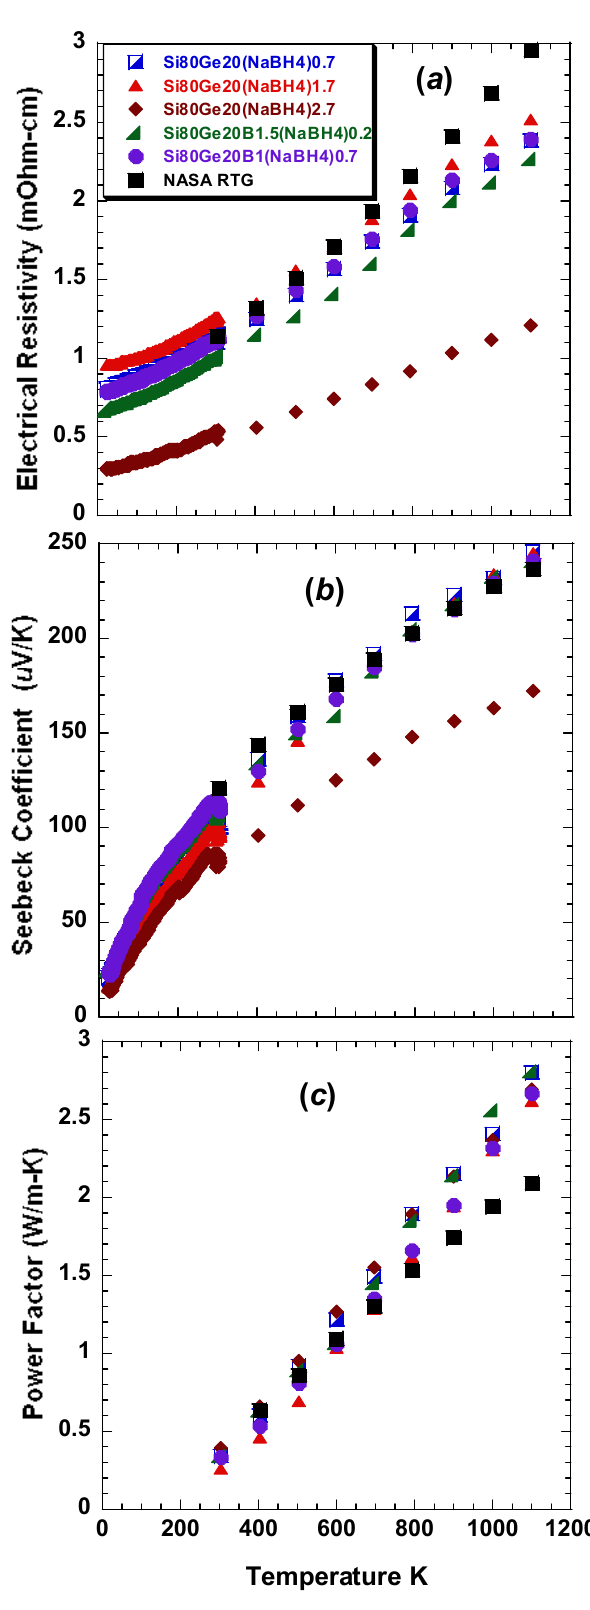
Figure 3. Temperature dependence of ( a ) the electrical conductivity; ( b ) Seebeck coefficient; and ( c ) power factor α (cid:2870) T/ρ , of five SPS prepared nanostructured dense bulk Si 80 Ge 20 alloy samples doped with (NaBH 4 ) x (x = 0.7,1.7 and 2.7) and B 1.7-y (NaBH 4 ) y (y = 0.2 and 0.7) in comparison to the p-leg material used in NASA’s